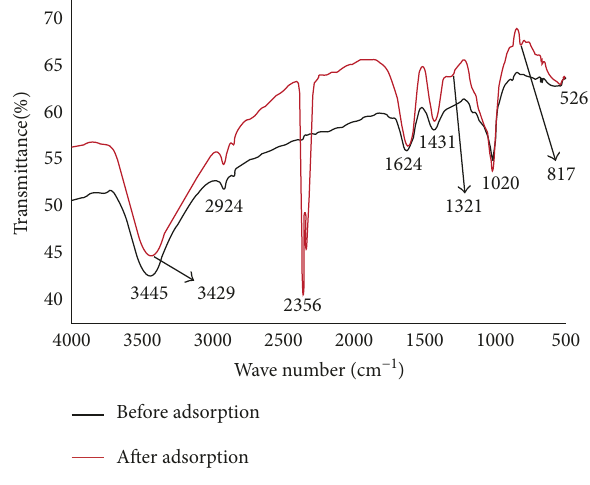
Figure 3: FTIR spectra of adsorbent